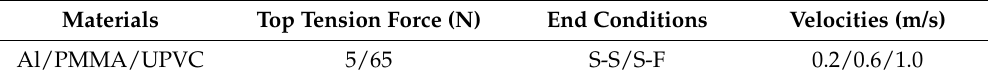
Table 2. Values for each parameter used in the experiment.